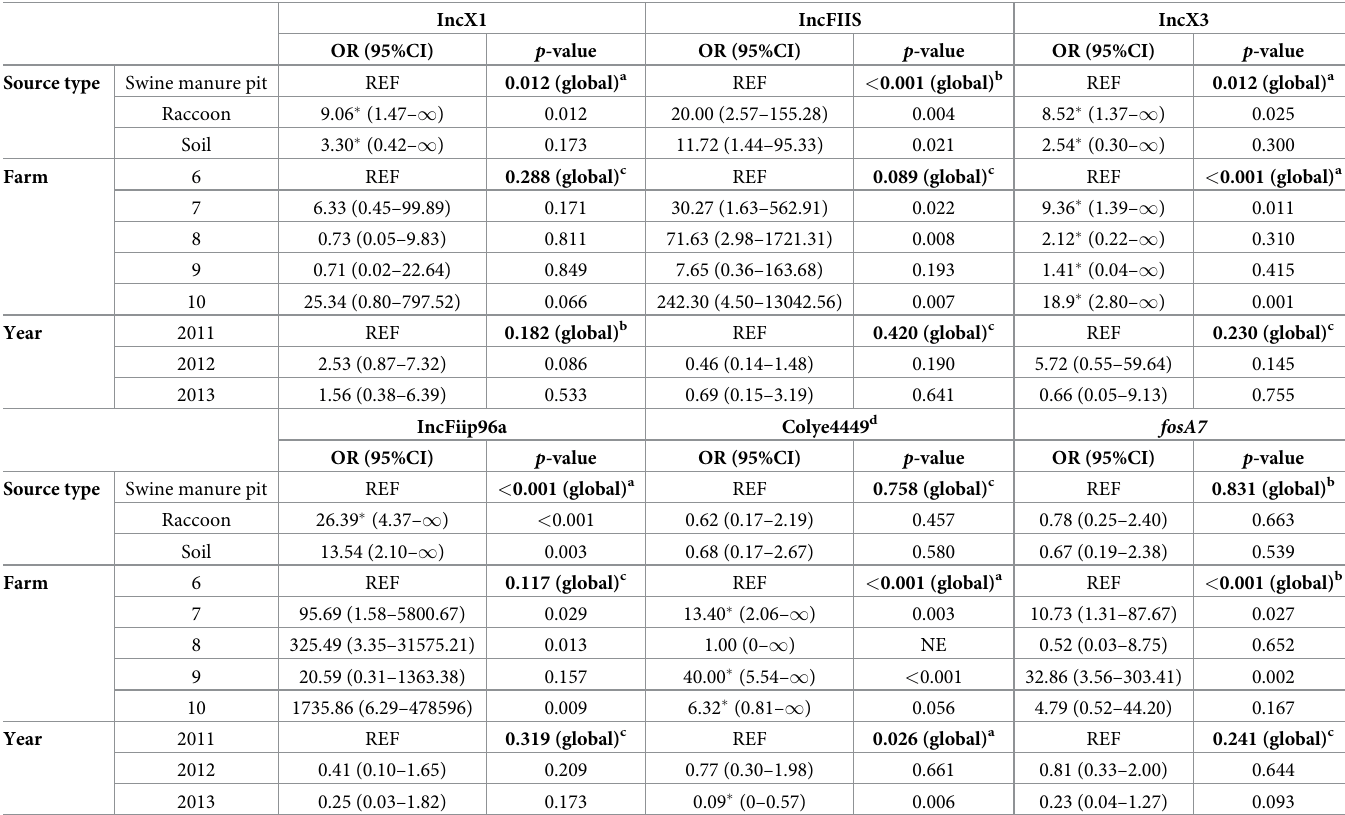
Table 6. Univariable logistic regression models a,b,c assessing the association between source type, farm location, and year of sampling and the occurrence of select antimicrobial resistance genes and plasmid incompatibility (Inc) types in Salmonella enterica isolates from raccoons, swine manure pits, and soil samples on swine farms in southern Ontario, Canada 2011–2013 (n =